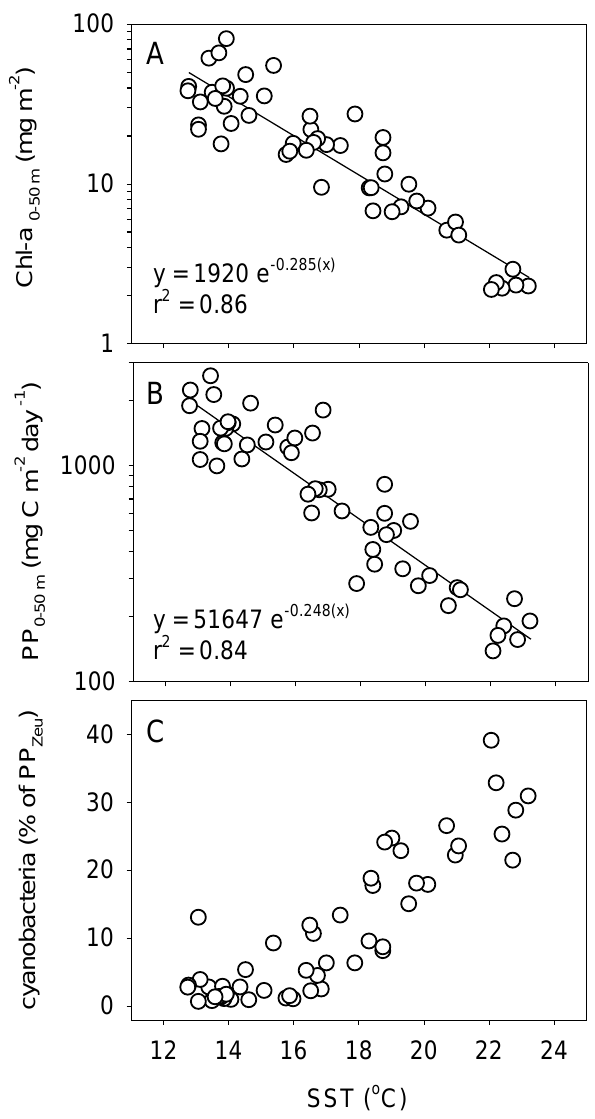
Fig. 6. (A) Relationship between depth-integrated (0–50m) Chl a (Chl a 0–50m ) and sea surface temperature (SST) for stratified sta- tions from the summer and spring cruise ( n = 52). (B) Relationship between depth-integrated (0–50m) daily productivity (PP 0–50m ) and SST for stratified stations from the spring and summer cruises ( n = 52). Note the exponential scales on the y-axes of graphs A and B. (C) Estimated productivity by cyanobacteria in the euphotic zone (group 1 and 2 combined) versus SST for stratified stations from the spring and summer cruises ( n = 52).